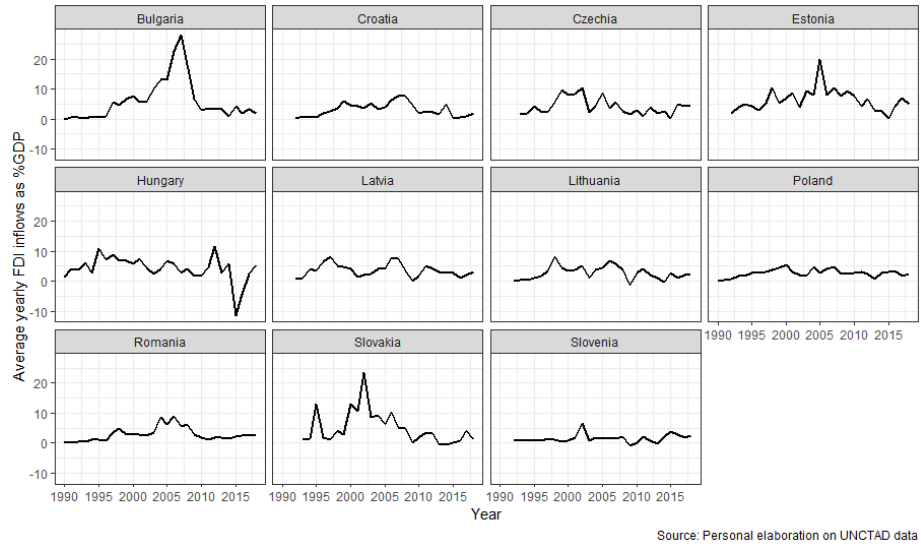
Figure A2 : Regional aid as % total aid in the CEECs by country